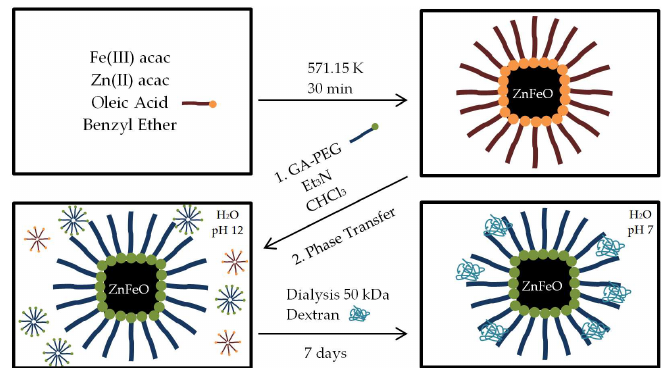
functionalization and a phase transfer to water, followed by a dialysis in a dextran solution. Figure 3. Schematic overview of single-core (SC)-SPIONs synthesis in organic media, subsequent